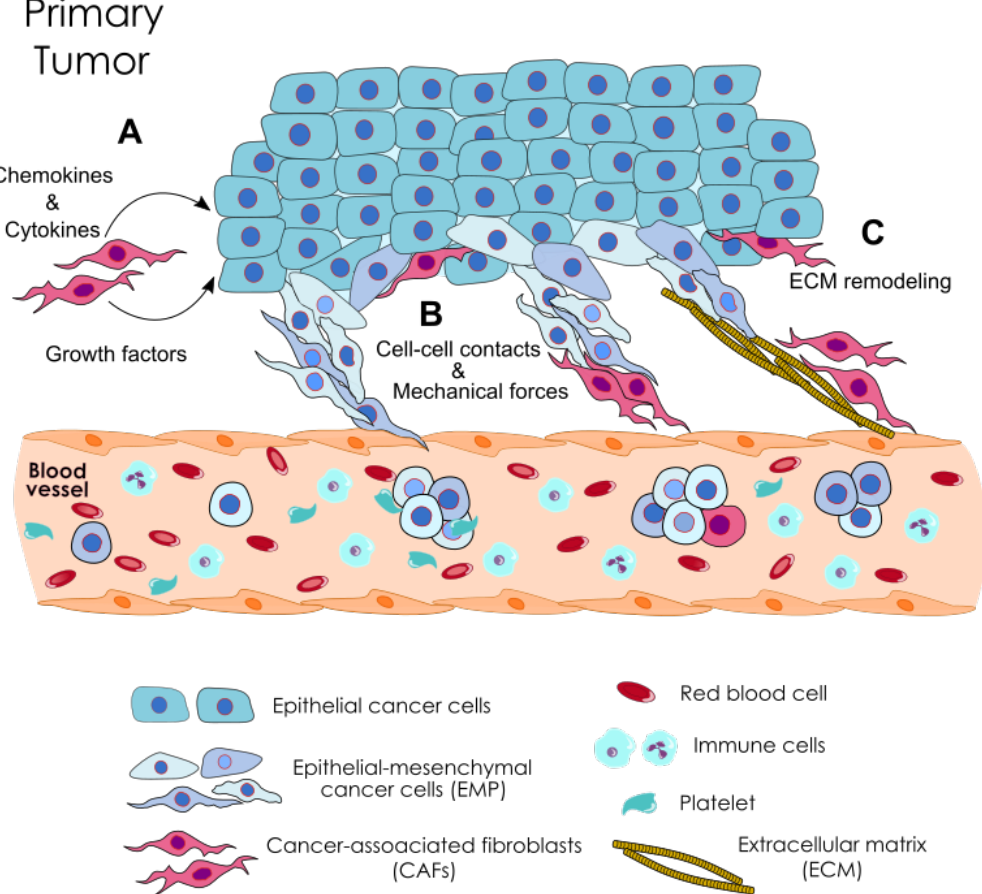
Figure 1. Role of CAFs on the formation of CTC clusters. CAFs can contribute to the formation of CTC clusters by at least three mechanisms. ( A ) CAFs secreted factors can reprogram cancer cells, inducing epithelial/mesenchymal plasticity, which endows an invasive phenotype. ( B ) CAFs exert